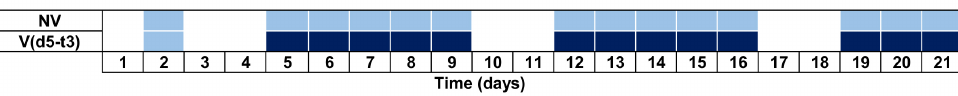
Figure 6. Timeline Experiment 3: Lifespan error experiment. White squares denote no data acquisition. Light blue squares depict data acquisition, but no stimulus. Dark blue ones represent data acquisition with a 3 s